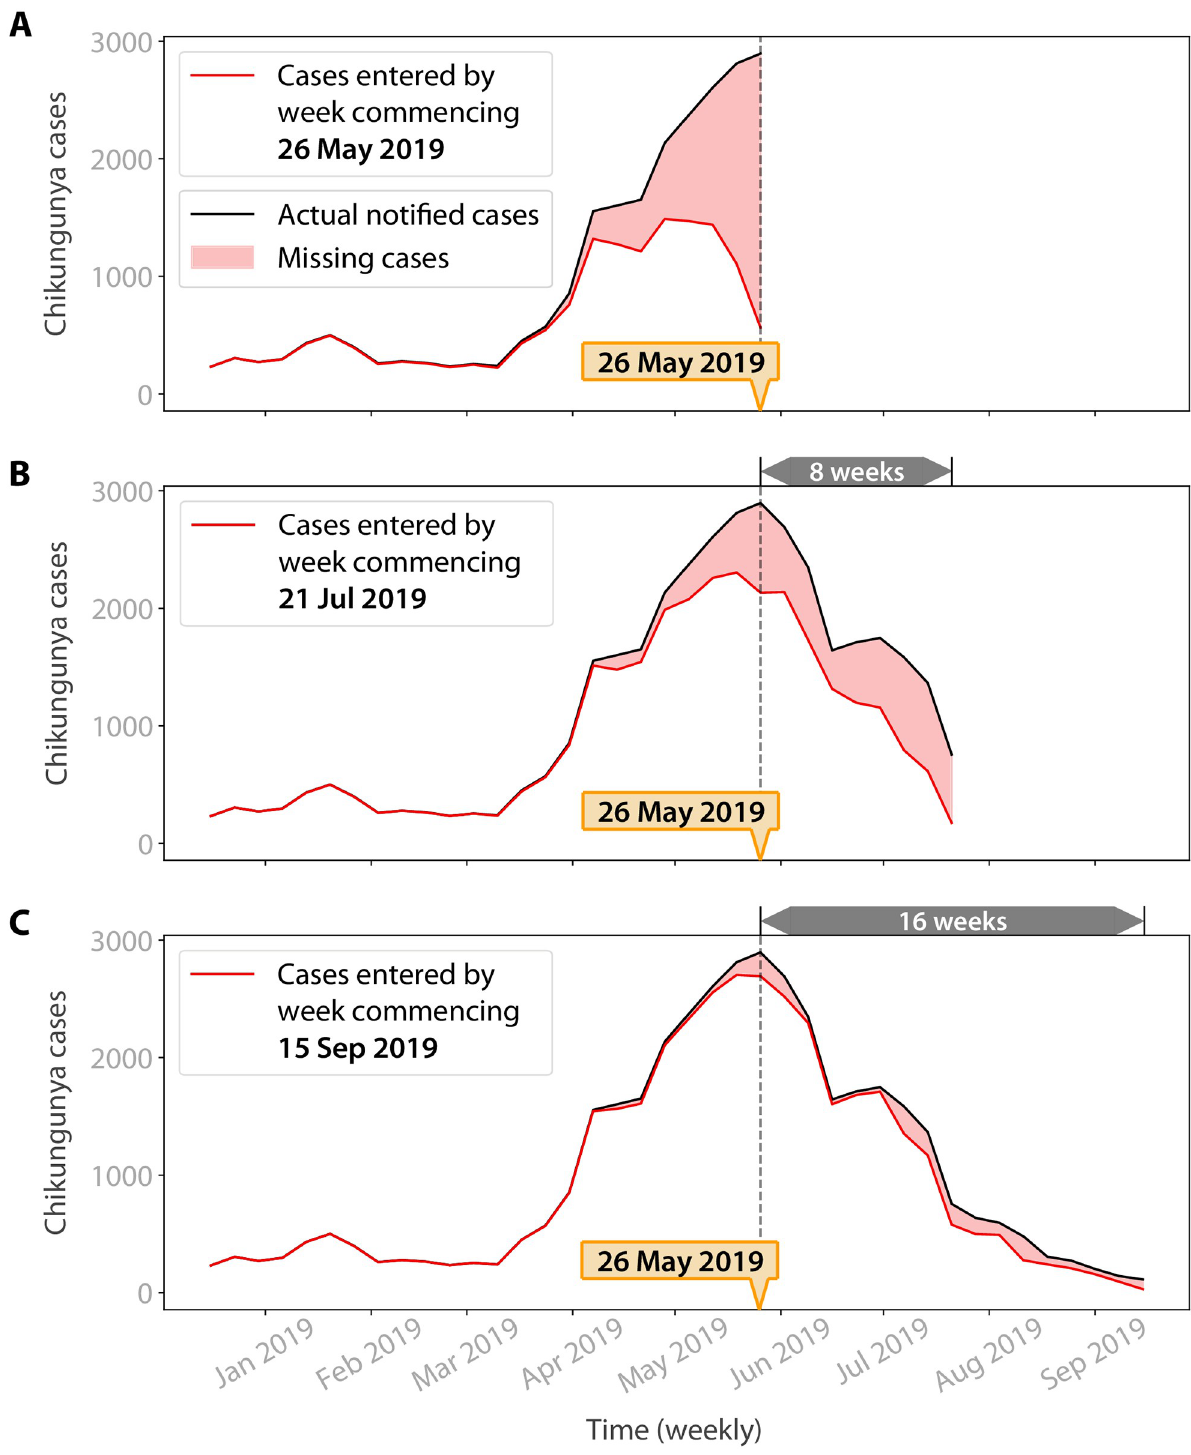
Fig 1. Chikungunya case data availability for an example week. Data on previous chikungunya cases arrives gradually and inconsistently. We illustrate this problem using the week commencing 26 May 2019: the peak of the 2019 epidemic in Rio de Janeiro. The black series show the true number of cases in each of the previous weeks. The red series show how many of these cases had been entered into the surveillance system by the end of the week. A) Only 20% of the 2,895 cases for the week commencing 26 May 2019 had been entered by the end of the week. B) The data is still very incomplete 8 weeks later, with only 74% of cases from the week commencing 26 May 2019 having been entered. C) The data is still not complete even after 16 weeks, with only 93% of cases from the week commencing 26 May 2019 having been entered. Data completeness is generally worse for more